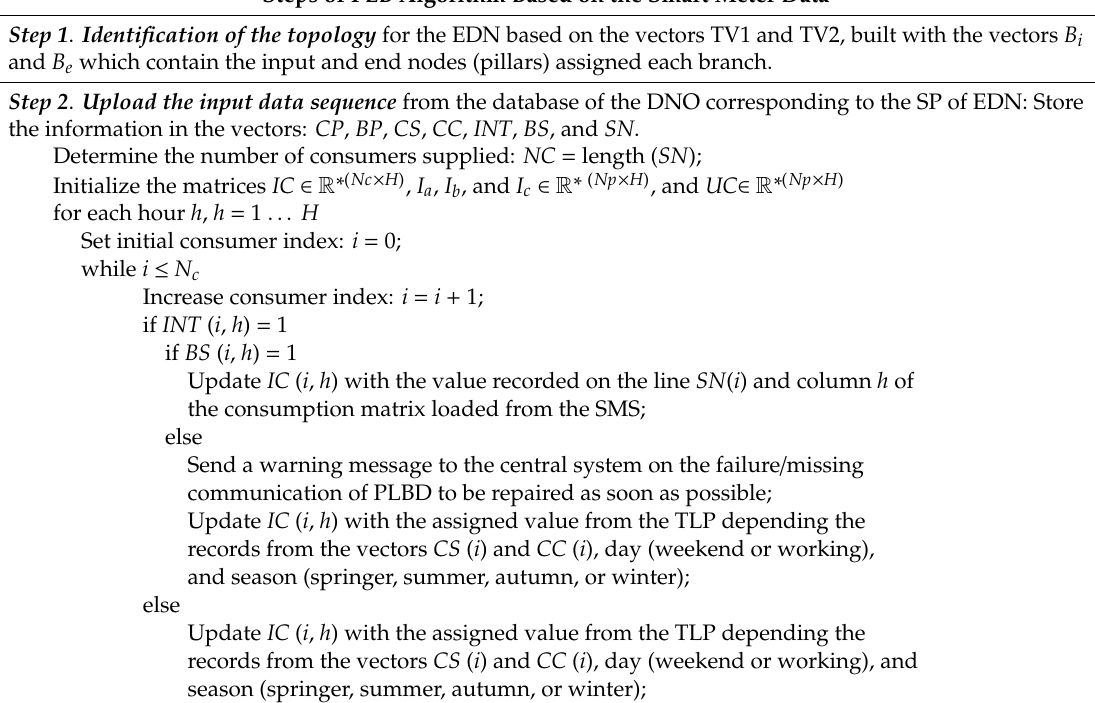
Table 3. The implementation procedure of the proposed phase load balancing (PLB) algorithm. Steps of PLB Algorithm Based on the Smart Meter